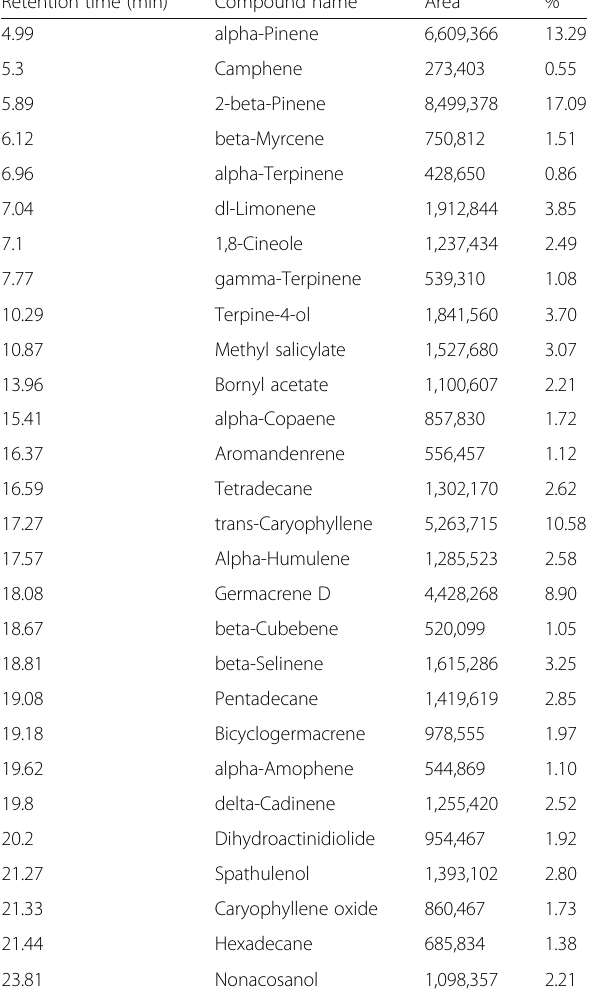
Table 1 Chemical composition of the Juglans regia L. (GRL) leaf extract Retention time (min)